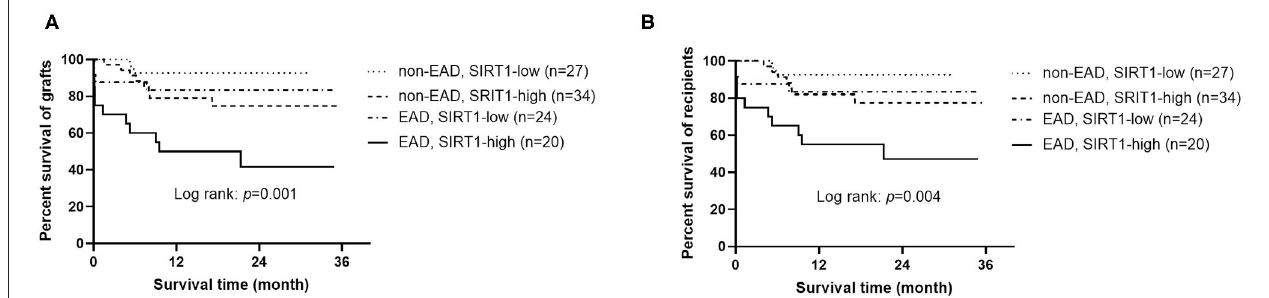
FIGURE 3 | Kaplan-Meier curves for grafts and recipients ( n = 105). (A) Graft survival according to the combination of EAD and SIRT1 expression. (B) Recipient survival according to the combination of EAD and SIRT1 expression. EAD, early allograft dysfunction; SIRT1, sirtuin